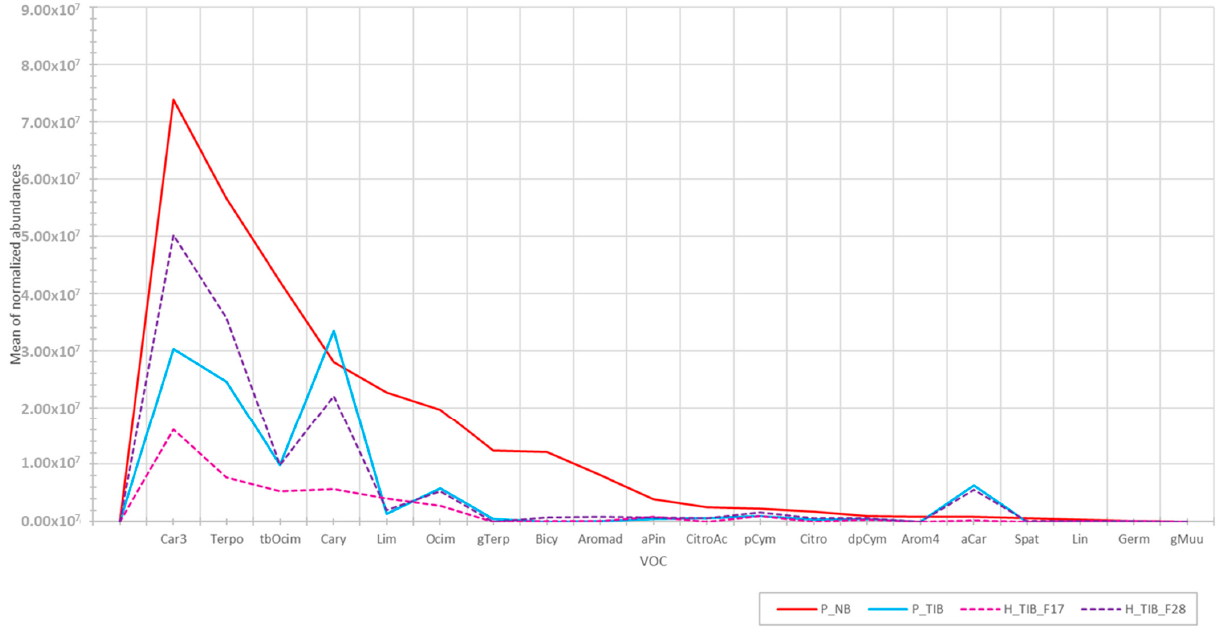
Figure 3. Profile in volatile compounds for Noir de Bourgogne (P_NB), Tiben (P_TIB), and two hybrid (H_TIB_F17 and H_TIB_F28) plants from their crossings (mean values of three